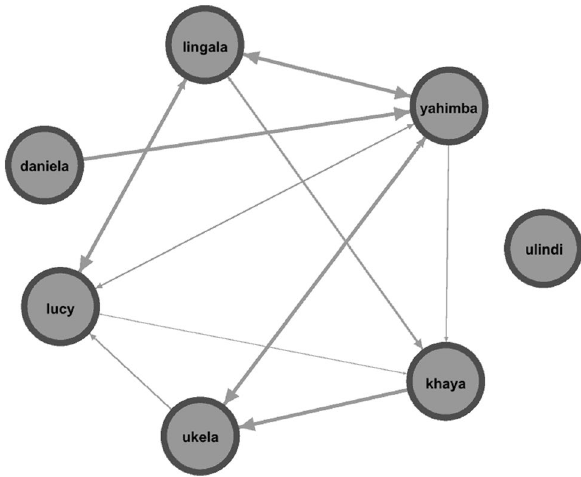
Figure 5. Swelling synchronisation network based on 5 years of data (2018–2022) obtained via freeware Gephi 0.9.7. The nodes are females (grey round circles), and edges show synchronization between females on the maximum swelling phase. In particular, directional edges go from the synchronizing female (follower) to the female eliciting synchronization (trigger). Synchronization occurred within 3